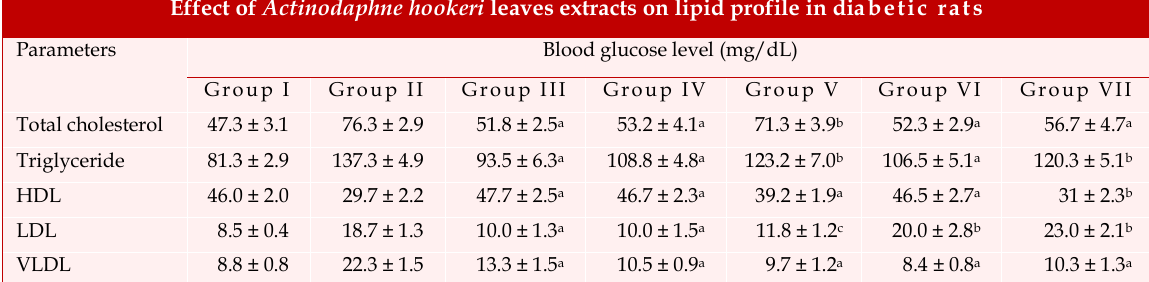
Effect of Actinodaphne hookeri leaves extracts on lipid profile in diabetic